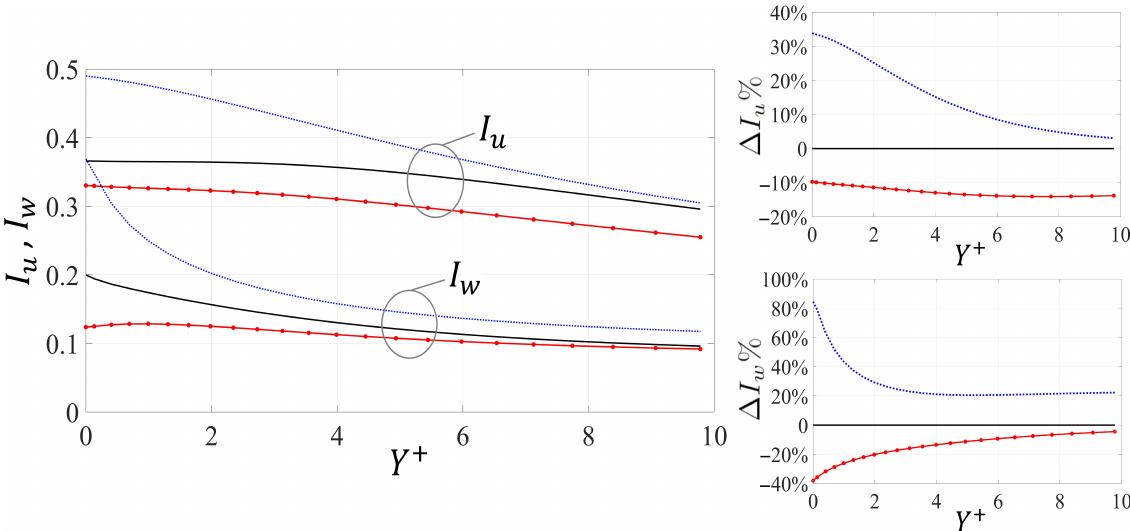
Figure 19. Turbulence intensities ( I u and I w ) near the permeable walls. The percentage deviations of the intensities from the reference smooth channel values are plotted in the right frames. Symbols are identical to those used in Figure